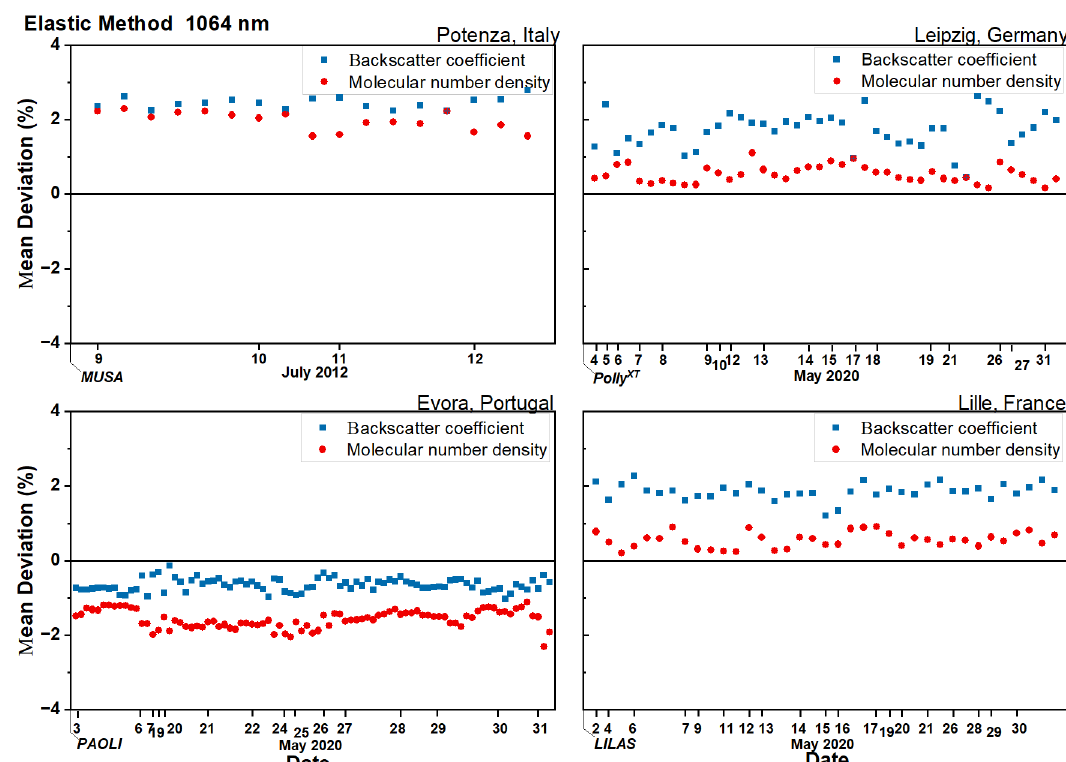
Figure 7. Same as Figure 5, but for 1064 nm.